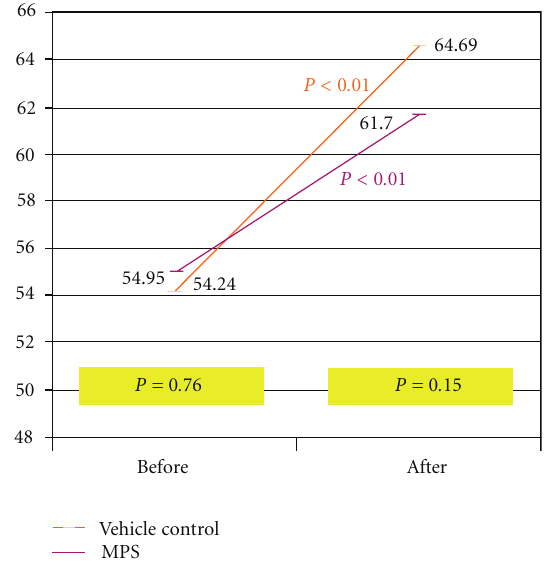
Figure 3: Skin hydration at MPS side was maintained for 10 hours after single